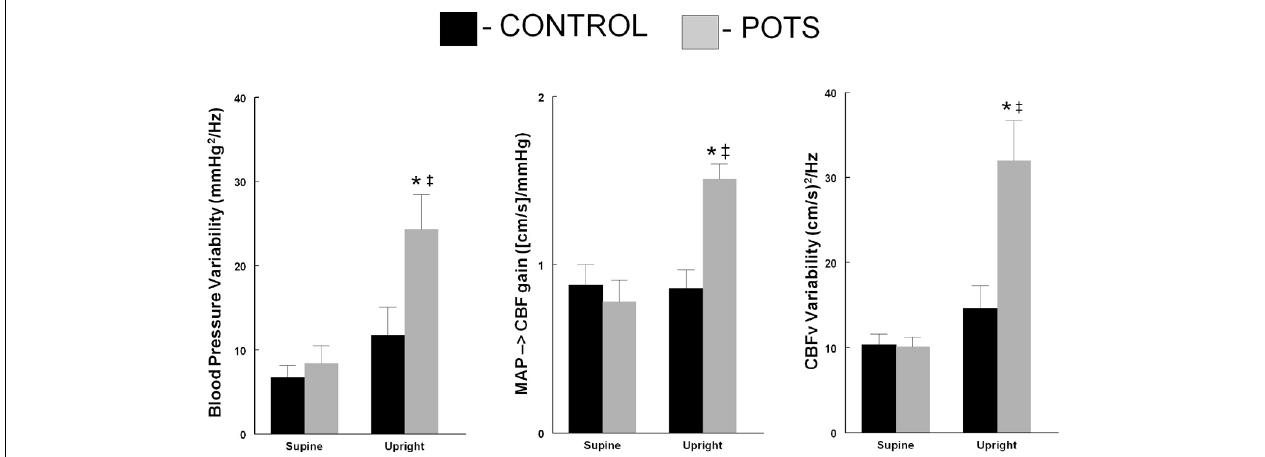
FIGURE 3 | Comparison of blood pressure variability (left panel), low frequency gain (Middle Panel) and cerebral blood flow velocity variability (right panel comparing control subjects ( (cid:2) )